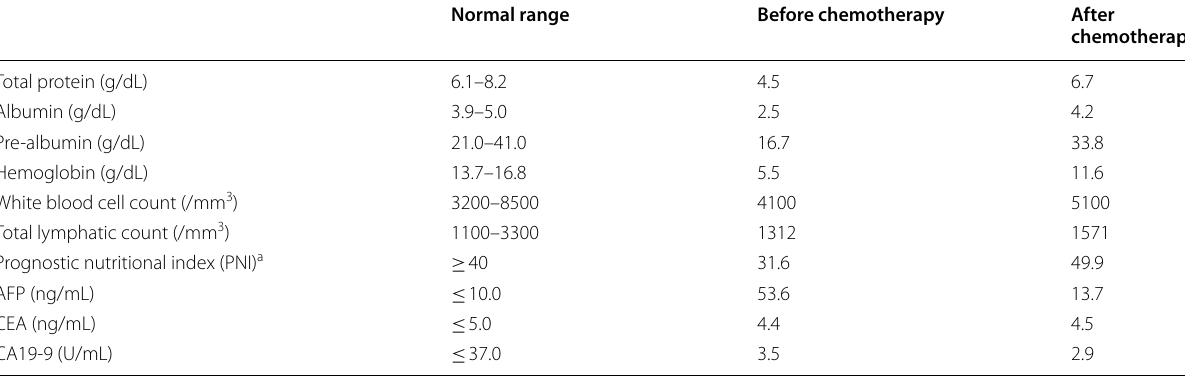
Table 1 Laboratory data before and after chemotherapy